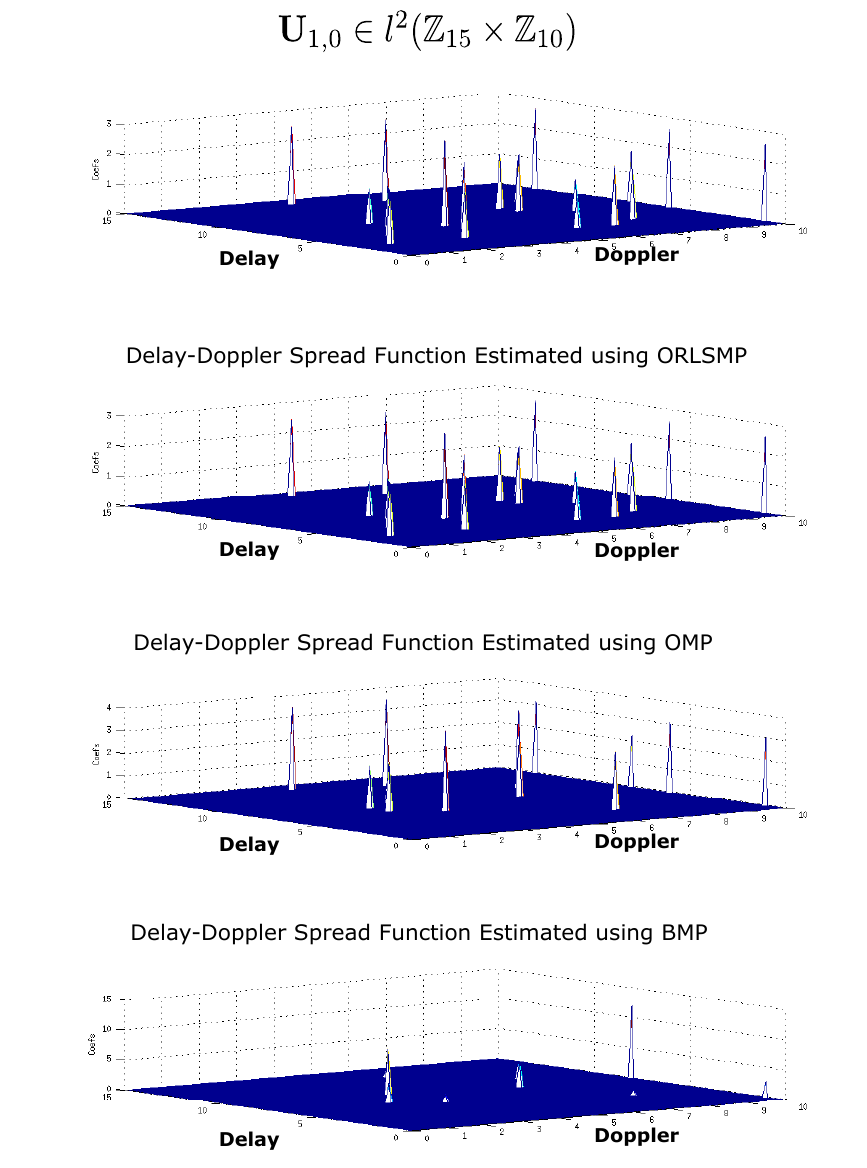
Figure 8. MIMO (2 × 2). Delay-Doppler spread function U 1,0